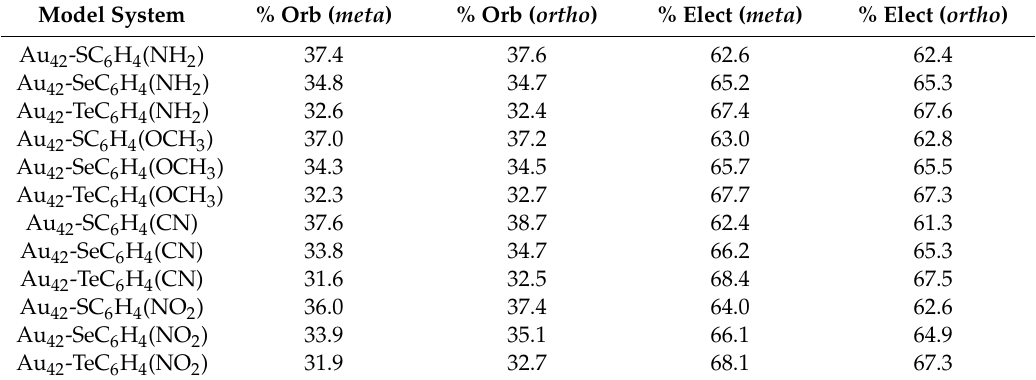
Table 3. Stabilizing contributions to the interaction energy calculated from EDA analysis between the ligands functionalized in meta and ortho position with the gold substrate